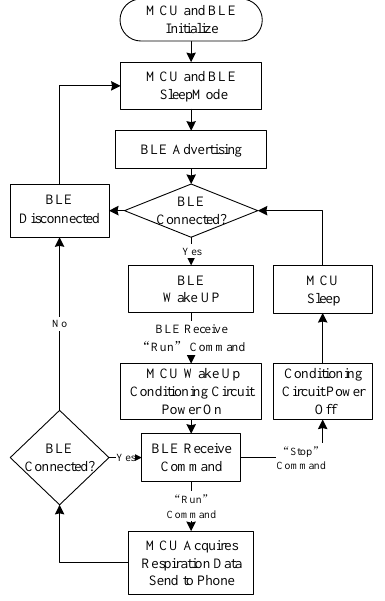
Figure 5. A flow chart of the SSRM.